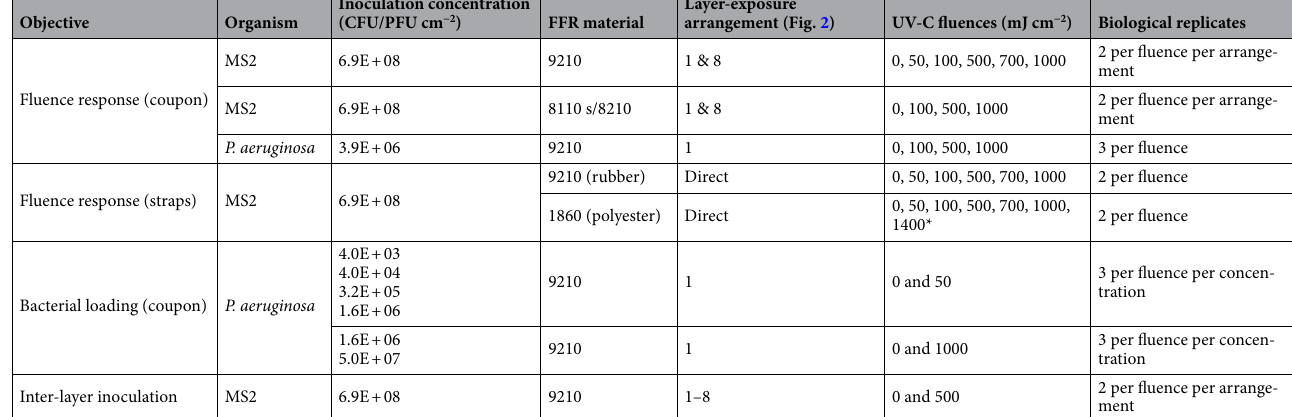
Table 1. Experimental summary of organism, inoculation concentration, FFR material, exposure arrangement, fluences, and replicates. *The polyester elastic absorbed the inoculation liquid; therefore, the elastic was flipped over after 700 mJ cm −2 to expose both